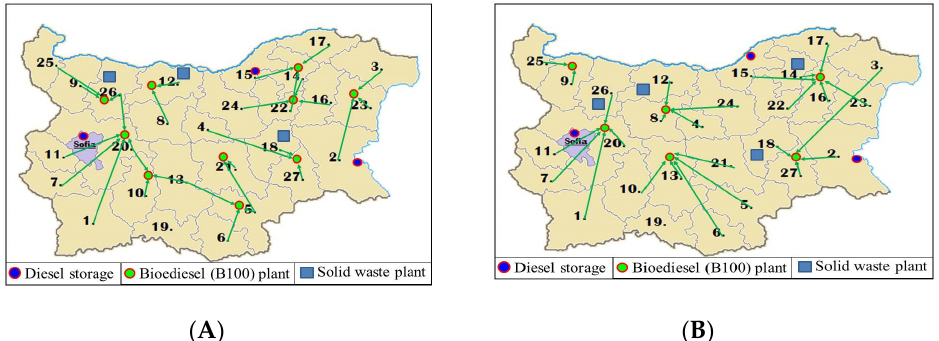
Figure 4. ( A ) Minimum total GHG emissions. ( B ) Minimum total annual costs. Optimal structure of IBDSC and logistics for delivery of animal fats and waste oils as feedstock for 2020.